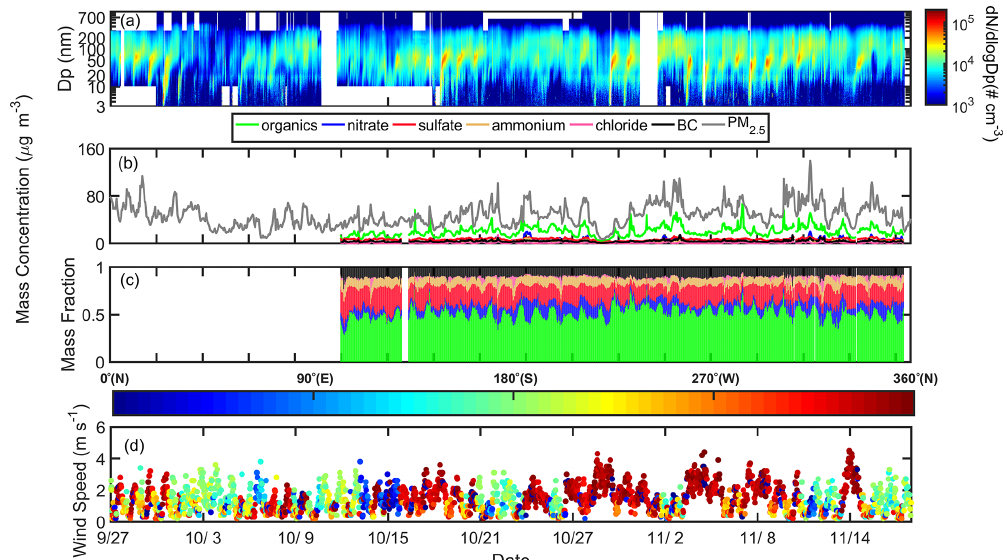
Figure 1. The temporal profile of the measured variables during the campaign. (a) Particle number size distribution; (b) PM 1 chemical composition measured by the SP-AMS along with mass concentration of PM 2 . 5 ; (c) mass fraction of each species; (d) wind speed and direction. The color code in (d) represents the wind direction.